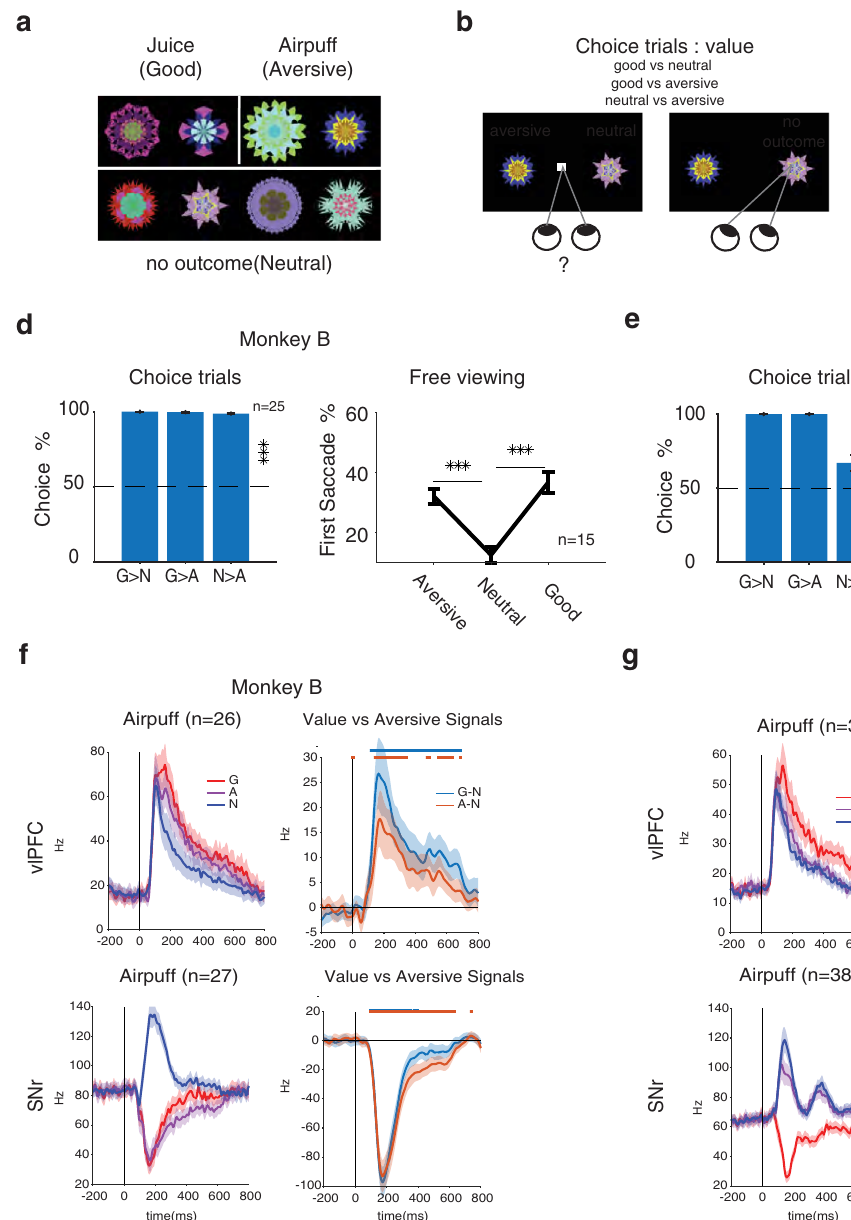
aversive(N>A)asameasureofvalence(MonkeyB:N>A, t 24 =99 p =6e-33Monkey R: N>A, t 12 =3 p =9e-3, two-sided). Free viewing gaze bias using fi rst saccade fol- lowing display onset toward aversive, neutral and good objects as a measure of salience (Monkey B: F 2,42 =19 p=9e-7, aversive vs neutral p =1e-4, Monkey R: p =2e-8aversivevsneutral p =0.7). f , g PopulationaveragePSTHtogood, F 2,30 =33 aversive and neutral objects and average value signal (good minus neutral) and aversive signal (aversive minus neutral) in vlPFC (top row) and in cdlSNr (bottom row) in passive viewing separately for each monkey. The horizontal lines indicate times of signi fi cant difference from zero ( p <0.01) for value and aversive signals (rightplots).Dataarepresentedasmeanvalues±SEM.Sourcedataareprovidedas a Source Data fi